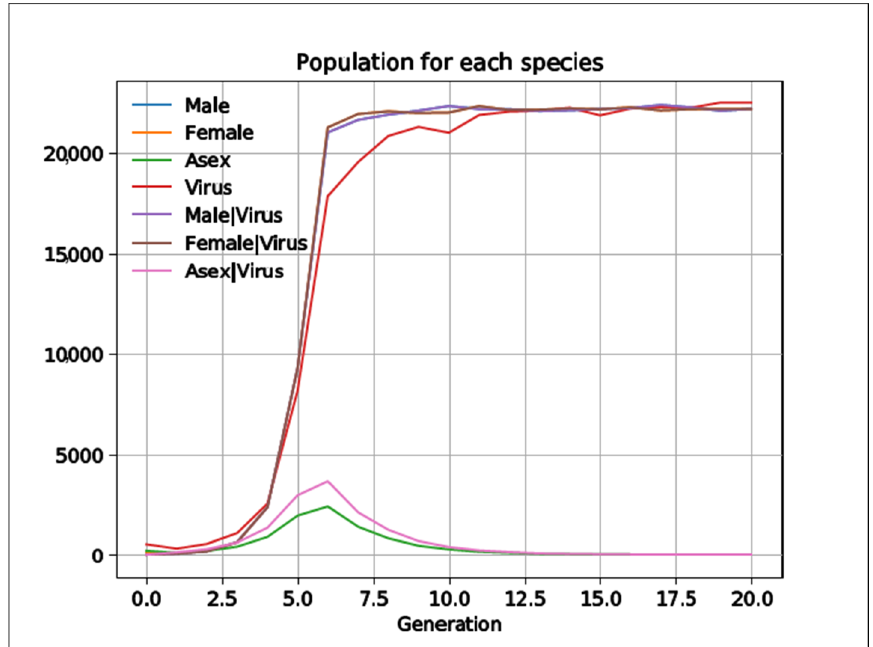
Figure 9. If the infection rate and lethality are higher among asexual species, sexual species prevail (data obtained from simulation 8 in 1Sex2.json in Supplementary Materials). When infections and pathogens’ lethality are simultaneously higher in the asexual populations, the sexual populations quickly overcome them.